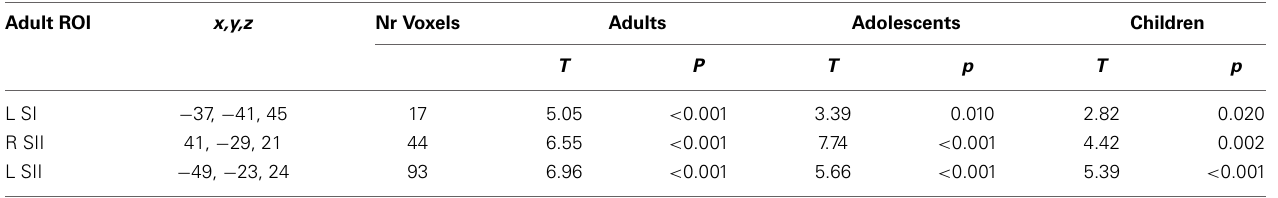
Table 2 | Adult somatosensory ROIs and activations for main effect of touch (Arm touch + Palm touch > Rest) in all age groups. Adult